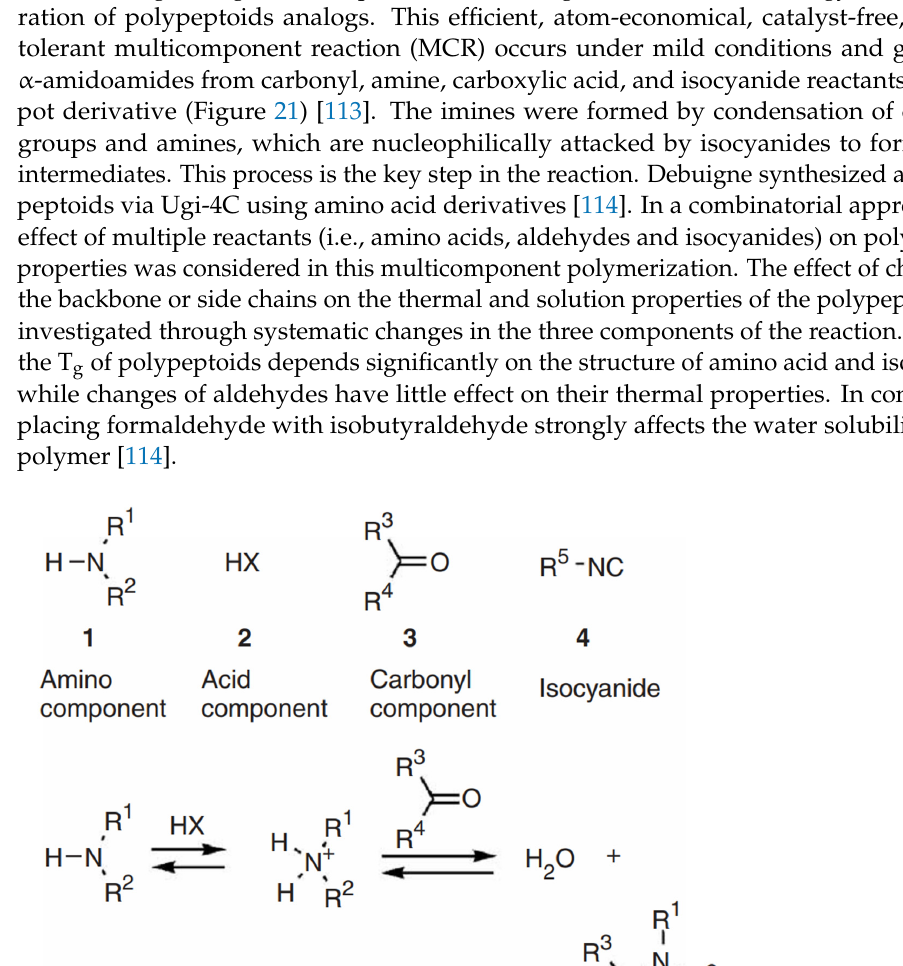
Figure 21. Scheme for the general mechanism of Ugi four-component reactions (Adapted from ref. [113]. Copyright 2007, Nature protocols).